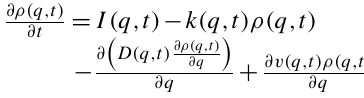
The initial quality distributions ρ ( q ,0)= ρ 0 (q) and two boundary conditions are also needed. Usually, F(q 1 , t) =0 and F(q 2 , t) =0 will be appropriate as boundary conditions,